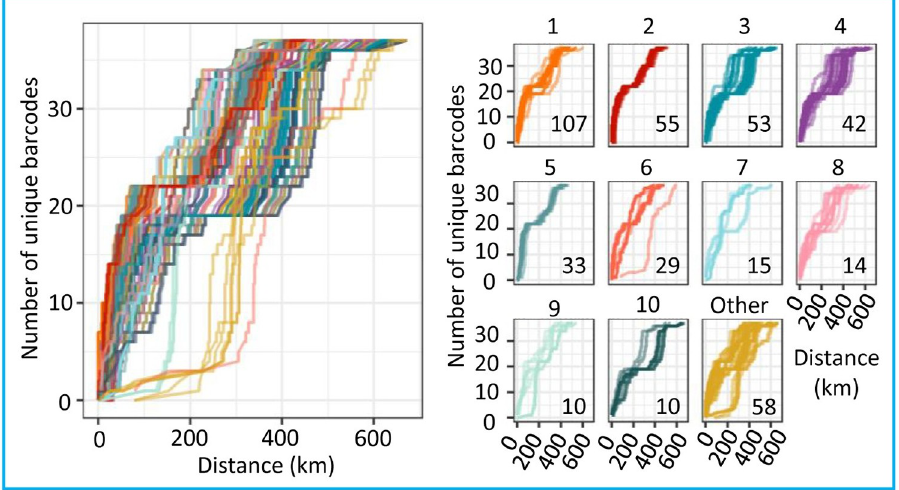
Fig 3. Opportunistic sampling does not drive apparent spatial connectedness of samples. Accumulation curves of worm cases on geographical proximity of barcode diversity show a consistent addition of diversity in quantitatively identified transmission ranges of barcodes sets ( < 50 kilometers). The left figure shows all accumulation curves for each worm case, and the right figure is separated by the barcode set number (1–10 for common barcodes, other for barcodes found in less than 10 samples). The numbers in the lower right corner are the number of worms in each barcode